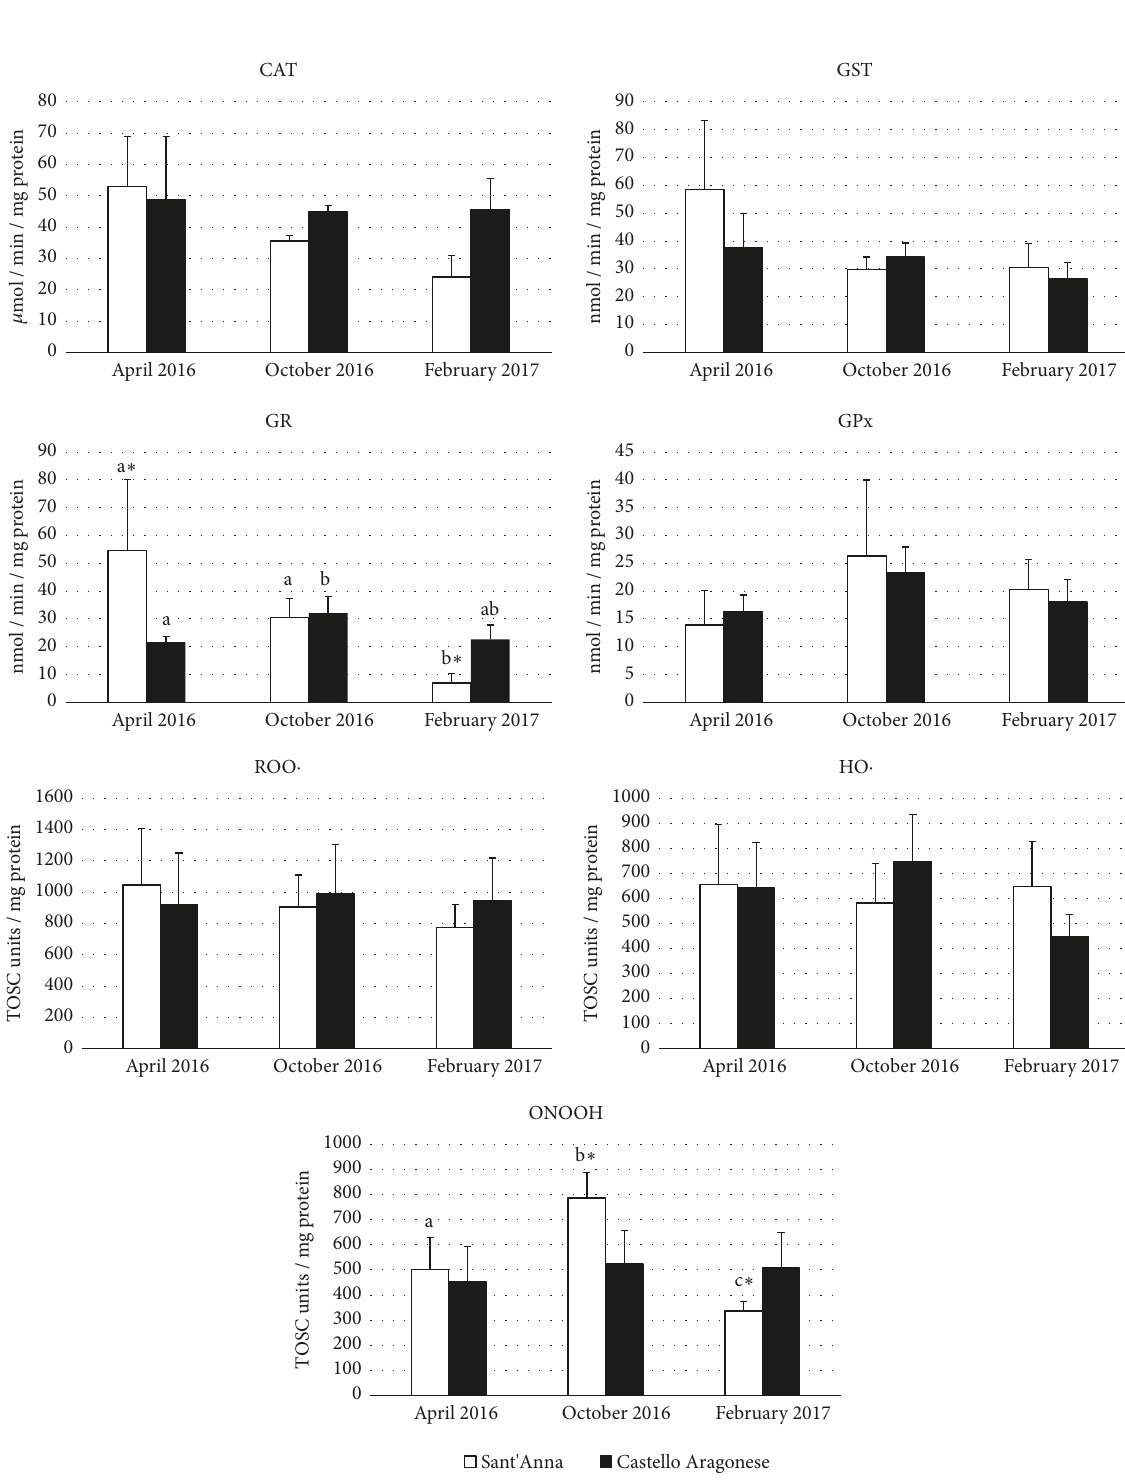
Figure 2: Basal antioxidant enzyme activities (CAT, GST, GR, GPx) and total oxyradical scavenging capacity (TOSC) toward peroxyl radicals (ROO ∙ ), hydroxyl radicals (HO ∙ ), and peroxynitrite (ONOOH) in Sant’Anna (white) and Castello Aragonese (black) Platynereis spp. populations. Values are expressed as 𝜇 mol min −1 mg −1 protein for CAT; nmol min −1 mg −1 protein for GST, GR and GPx; TOSC units/mg protein for ROO ∙ , HO ∙ , and ONOOH. Letters indicate significant differences among sampling periods (𝑝 < 0.05) , while asterisks indicate significant differences between Sant’Anna and Castello Aragonese Platynereis spp. populations (𝑝 < 0.05) (PERMANOVA pairwise post hoc